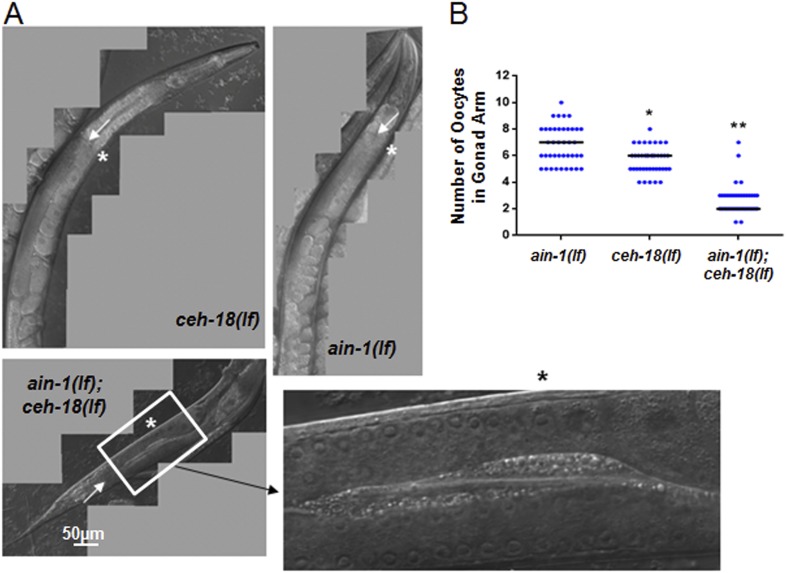
ain-1(lf);ceh-18(lf) double mutants have reduced oocytes.DIC images of gonads from single and double mutant animals. (A) Arrows indicate the farthest point for the gonad turn. Asterisks are located near the first identifiable oocyte in the given gonad arm. The expanded segment is a digital zoom-in to show the morphological detail of the double mutant gonad for the indicated segment. (B) Dot plot of the oocyte counts per gonad arm (n = 40 for each strain). Each dot represents the number of oocytes in one gonad arm and the median values are given by black bars for each strain (p < 0.001, *compared to ain-1(lf) and **compared to both ain-1(lf) and ceh-18(lf) alone, Mann–Whitney test). The distinct phenotypes observed amongst some of the genetic interactors, such as ced-3 (shown in Figure 2) vs ceh-18 suggest distinct physiological functions and argue against general sickness of the single mutants. This conclusion is also supported more broadly by the frequency of phenotypes observed (Figure 1—figure supplement 1B) such that equal frequency is not observed across the various phenotypes.